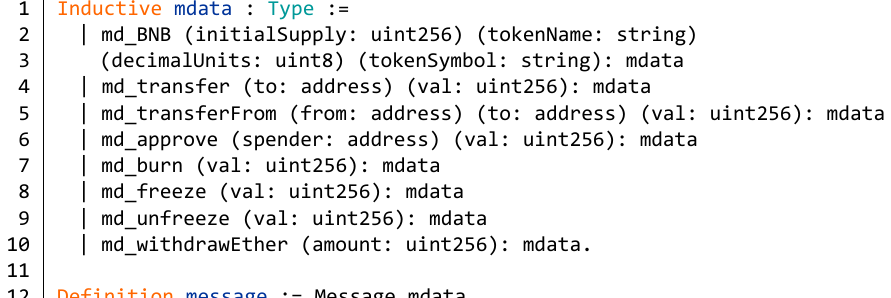
Figure 16. The specific message data and model of the BNB